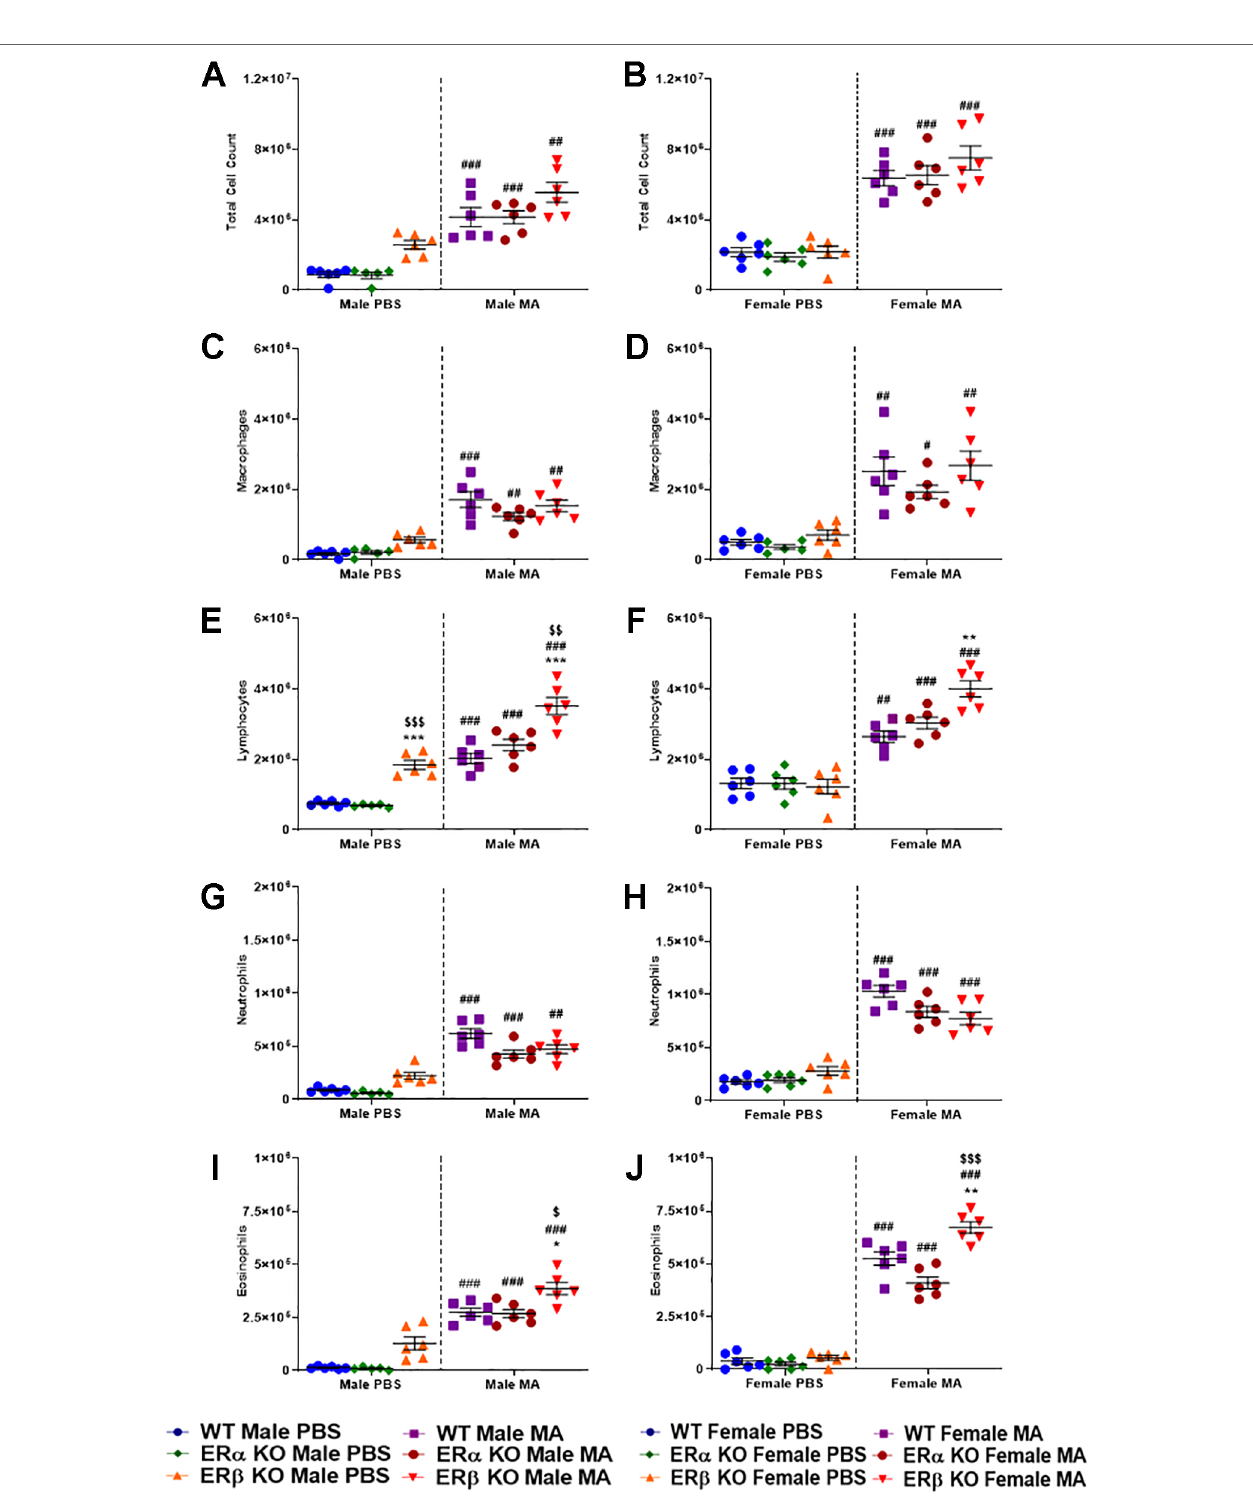
FIGURE 7 | Effect of ER signaling on total and differential leukocyte count. Dot blots showing total cell count in (A) males and (B) females; Macrophage count in (C) males (D) females; Lymphocyte count in (E) males and (F) females; Neutrophils count in (G) males and (H) females and Eosinophils count in (I) males and (J) females. Data represented as mean ± SEM of at least 6 mice per treatment group; # p < 0.05, ## p < 0.01, ### p < 0.001 vs. PBS of respective groups (MA effect) and *p < 0.05, **p < 0.01 vs. WT of PBS/MA (ER speci fi c KO effect) and $ p < 0.05, $$ p < 0.01, $$$ p < 0.001 vs. ER a KO of PBS/MA (ER b vs. ER a